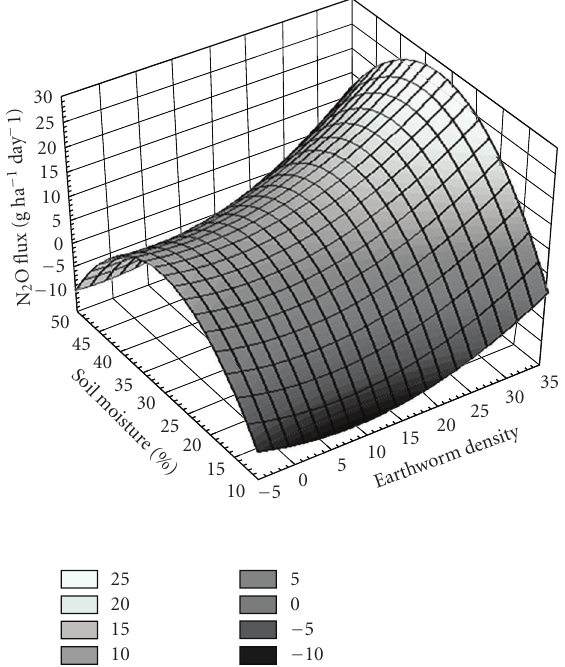
Figure 3: A response surface regression showing the relationship between N 2 O flux (kgha − 1 day − 1 ), gravimetric soil water content (%), and earthworm density (number of earthworms 0.033 m − 2 ). Equation of the line is 36 . 7186 − (0 . 36143 ∗ D ) + (3 . 1095 ∗ M ) + (0 . 0174 ∗ D ∗ D )+(0 . 00810 ∗ M ∗ D ) − (0 . 0518 ∗ M ∗ M ) ( R 2 = 0 . 17, P ≤ . 0001), where D is earthworm density and M is gravimetric soil water content.